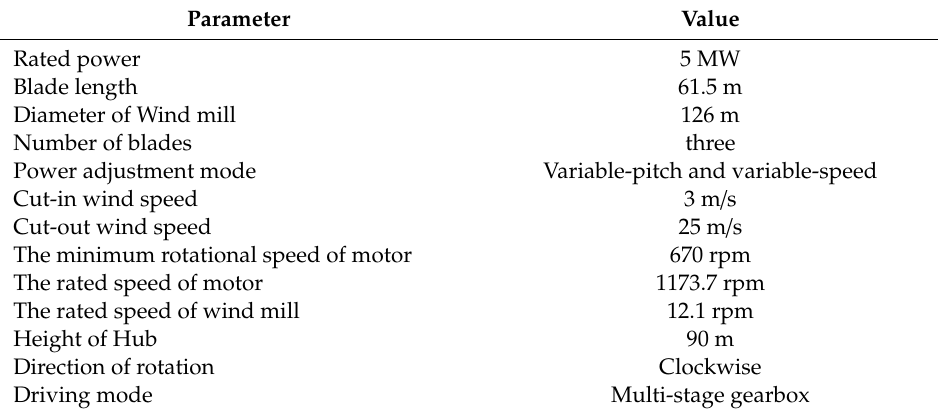
Table 2. Overall technical parameters of the NREL 5 MW wind turbine [17].